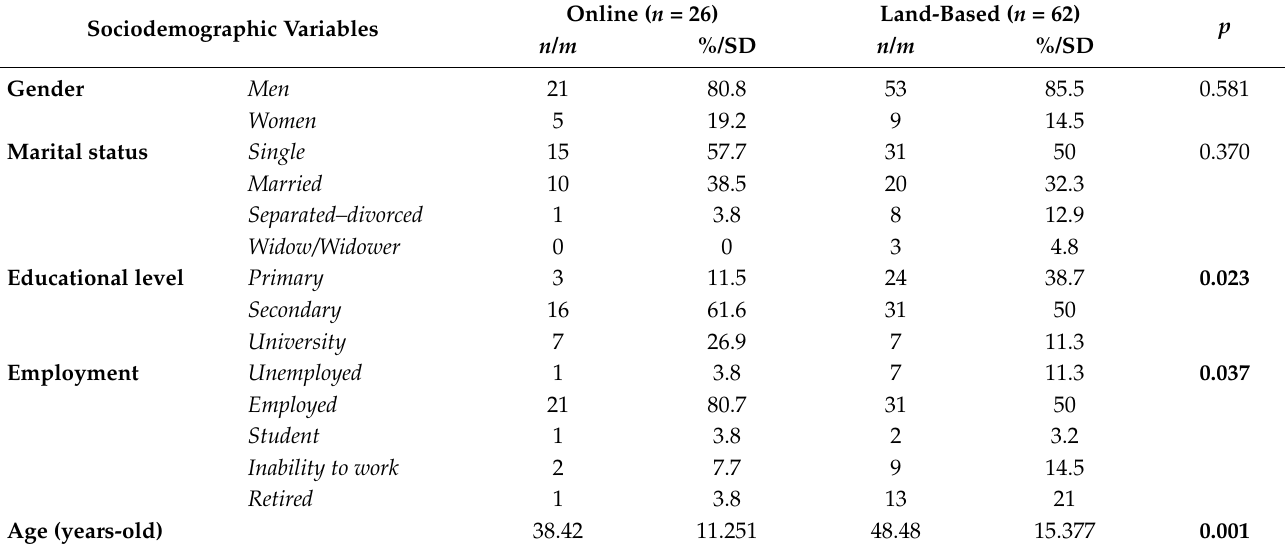
Table 2. Comparison between online and land-based gambling subgroups regarding sociodemographic characteristics. Sociodemographic